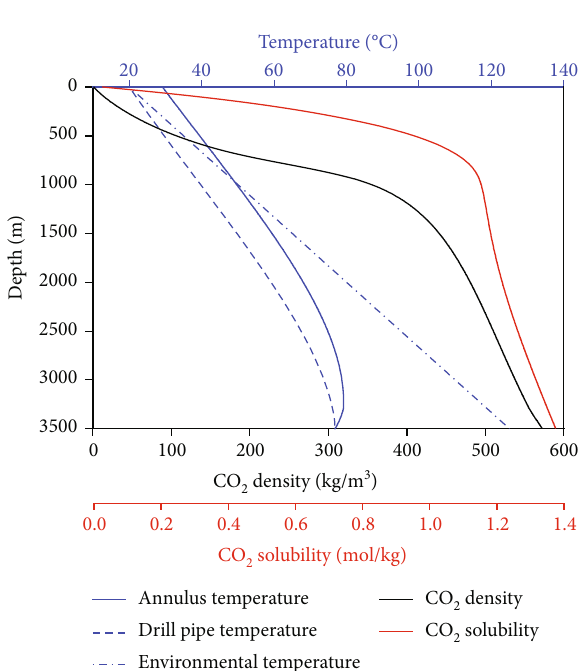
Figure 3: The distribution of fl uid temperature and CO and solubility in the wellbore at 500